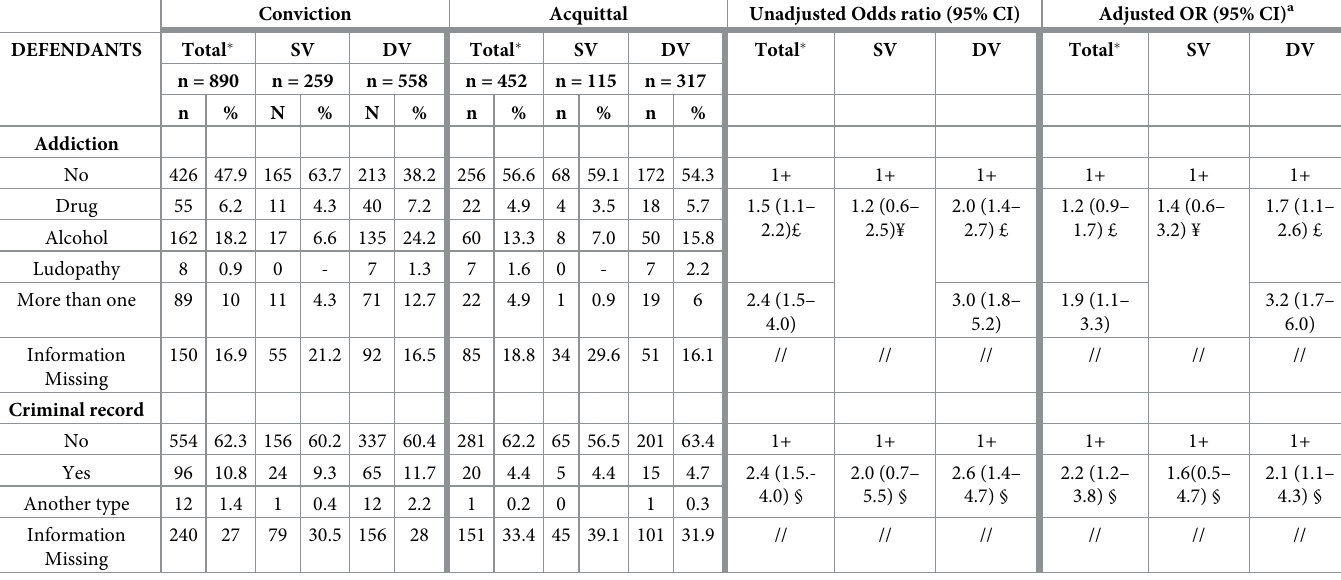
Table 3. Distribution of defendants according to addiction and criminal records. Conviction